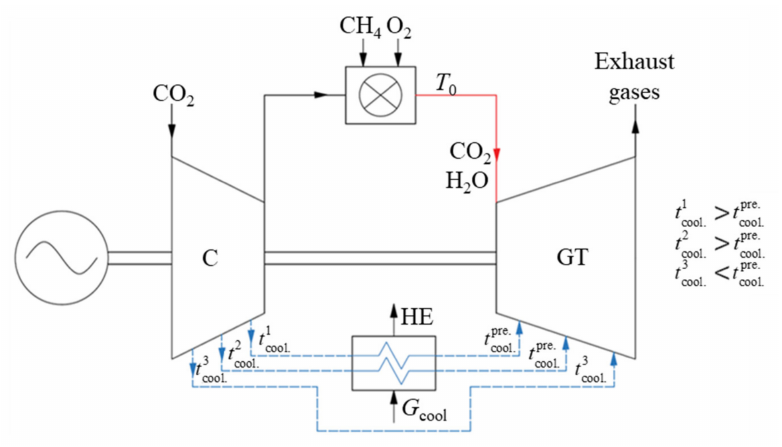
Figure 8. The SCOC-CC cycle coolant preliminary cooling in a surface heat